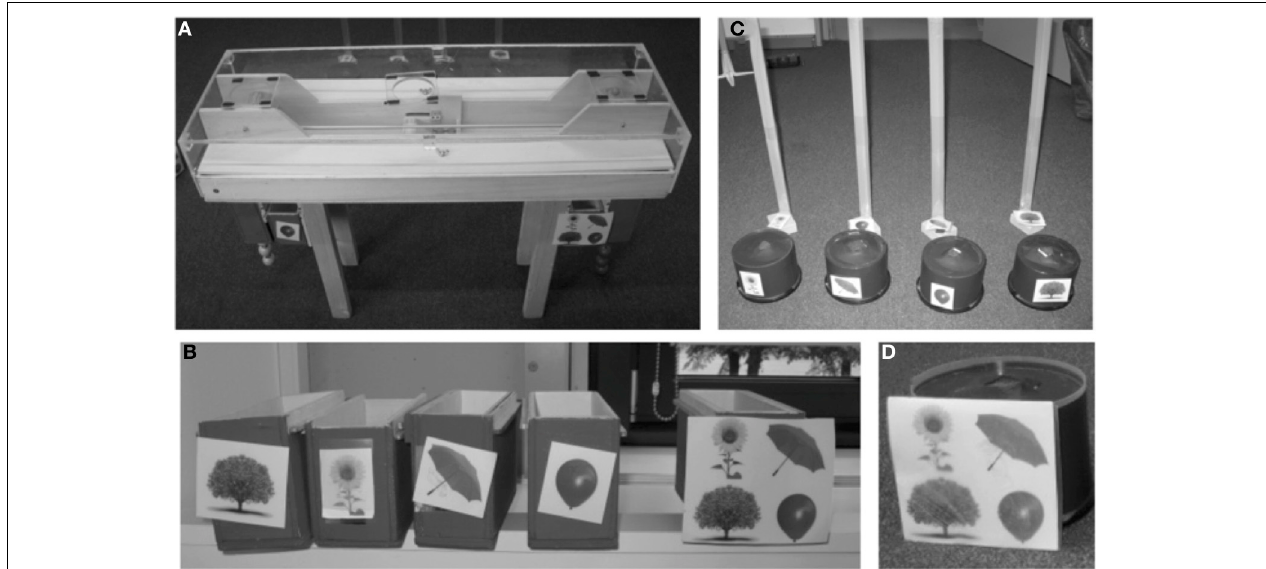
FIGURE 1 | (A) Distributing apparatus (distributor). Two ropes can be pulled, resulting in gumballs to roll off the apparatus into private or public boxes. Choosing the private option causes two gumballs to fall into the private collection box (shown on the left) and two gumballs to fall into a trashcan (not shown). Choosing the public option causes all four gumballs to fall into the